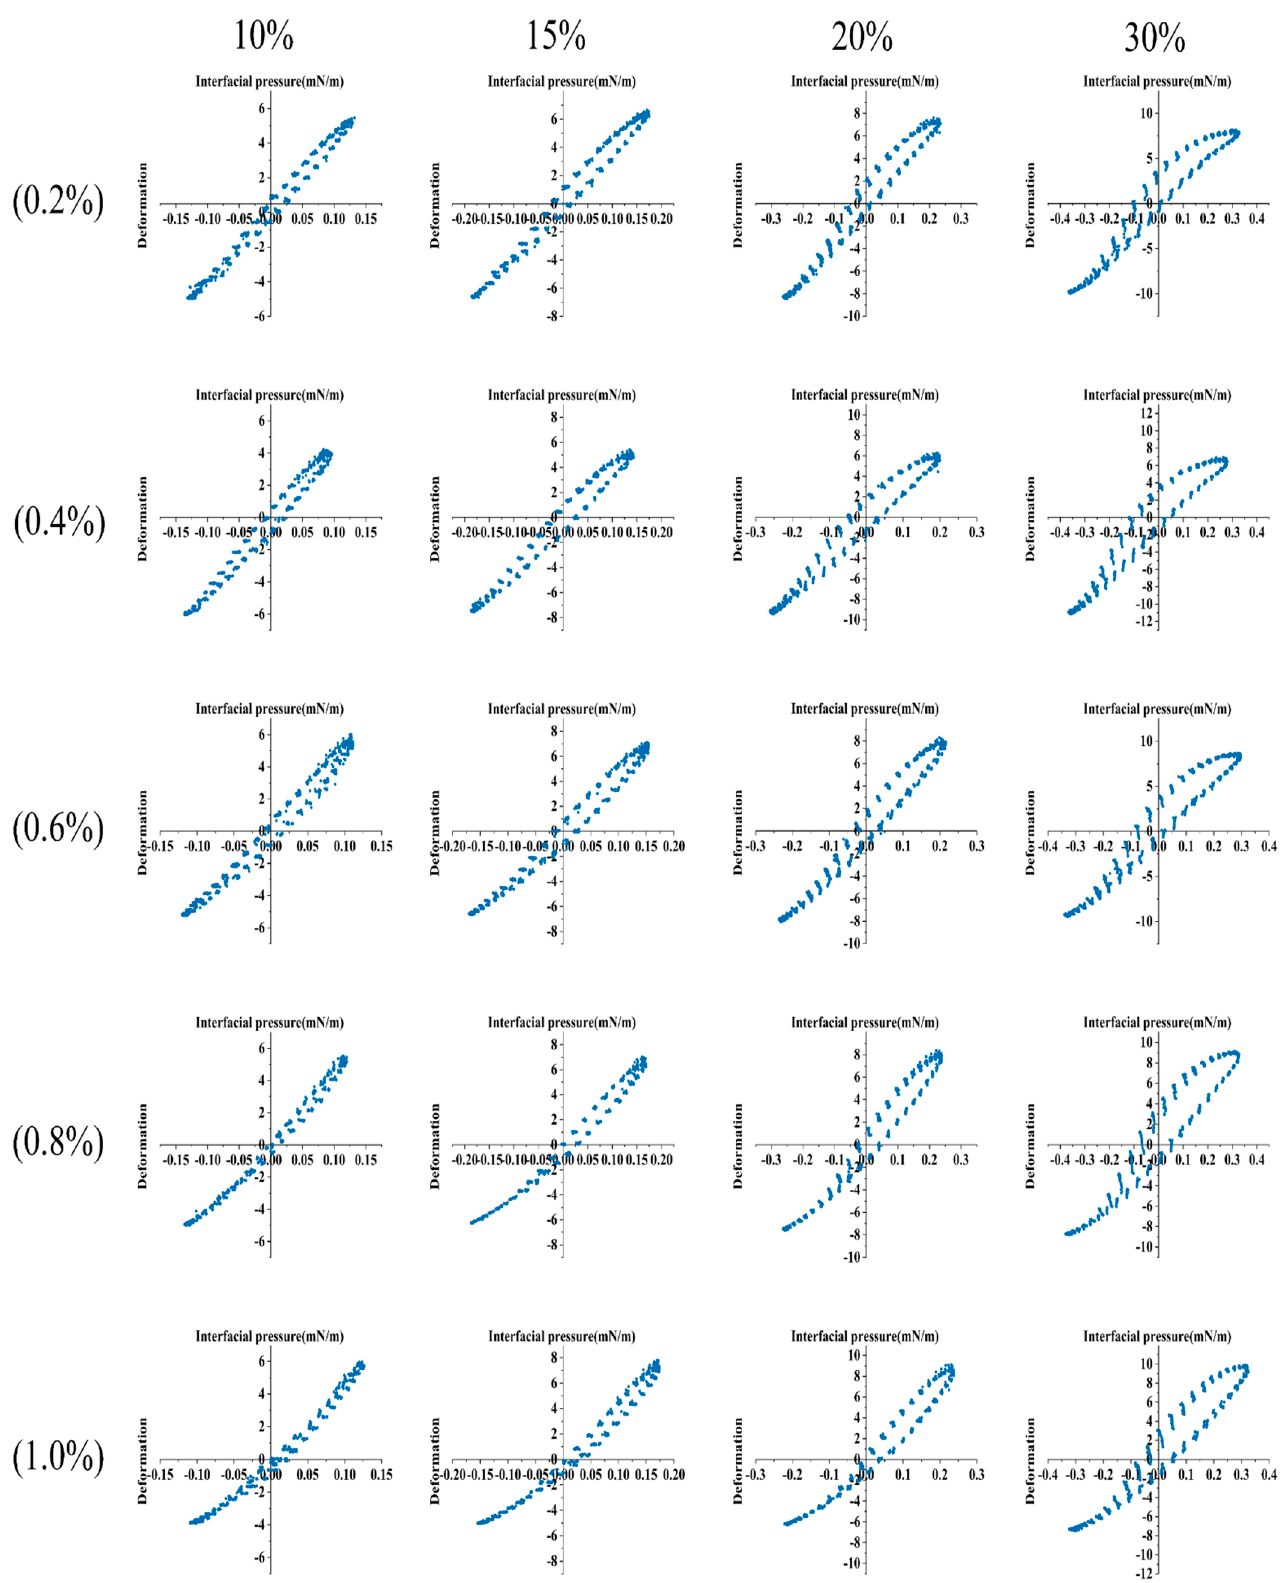
Figure 7. Lissajous plots for different concentrations (0.2–1.0%) of LSEP with various amplitude of deformation (10 − 30%).